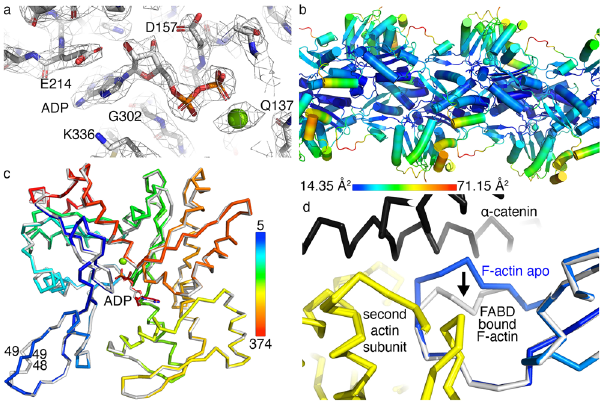
Fig. 4 The 2.7 Å cryoEM structure of F-actin. a Coulomb potential map showing adenosine diphosphate binding. Green sphere, magnesium. b The cryoEM structure of F-actin shows the temperature factors as